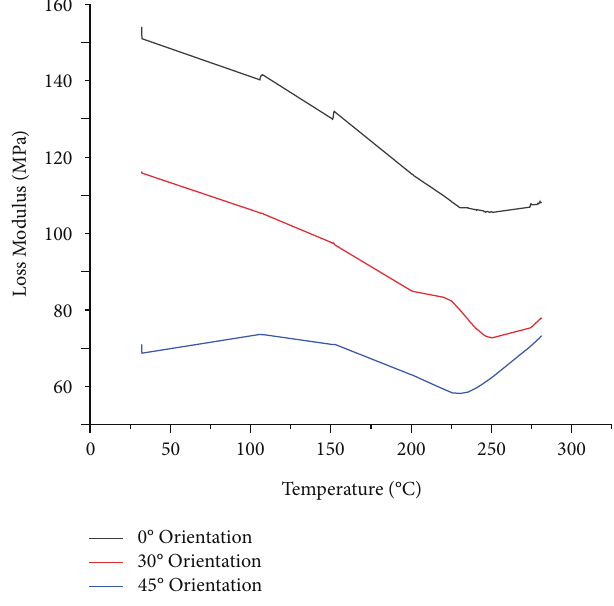
Figure 3: Temperature versus loss modulus of the basalt fi ber reinforced with anamide composites at di ff erent orientations and a frequency of 1